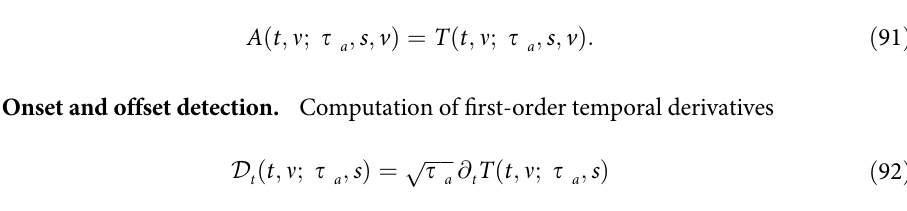
ffiffiffi p 2 ). The first four columns show separable receptive fields